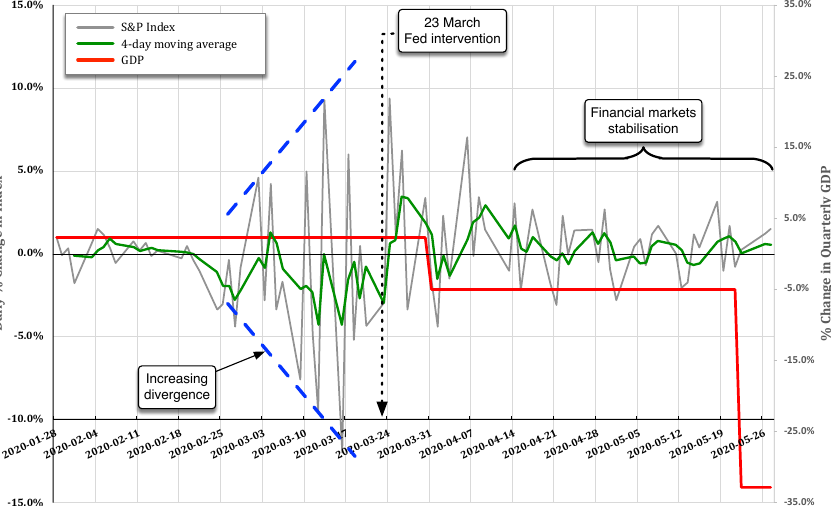
Figure 9. Daily % variation in S&P Index during the 2020 pandemic (BEA 2020b; NASDQ